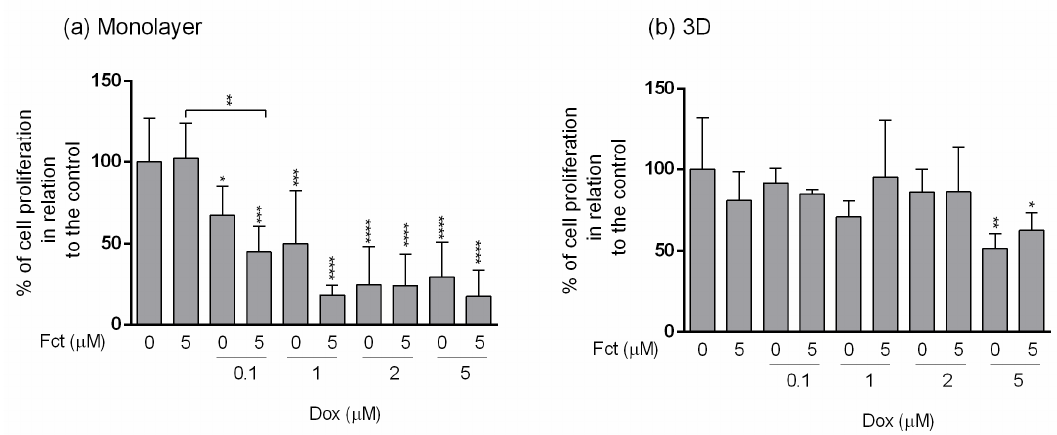
Figure 10. Effect of fucosterol (Fct) at 5 µ M alone and in combination with doxorubicin (Dox) at 0.1, 1, 2, and 5 µ M, on cell proliferation in monolayer–72 h ( a ) and 3D–96 h ( b ) assessed by BrdU assay. Cells treated with 0.1% DMSO and Dox 5 µ M were included as negative and positive controls, respectively. The percentages of cell proliferation are relative to the control and presented as mean + standard deviation of five independent experiments (each in triplicate). (* p < 0.05, ** p < 0.01; *** p < 0.001; **** p <